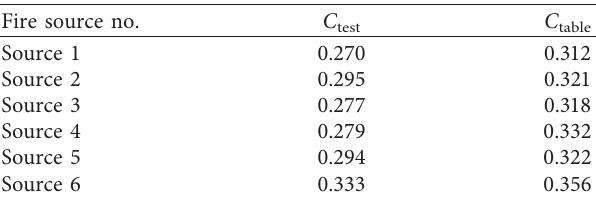
Table 6: Results obtained from tests of fire in confined